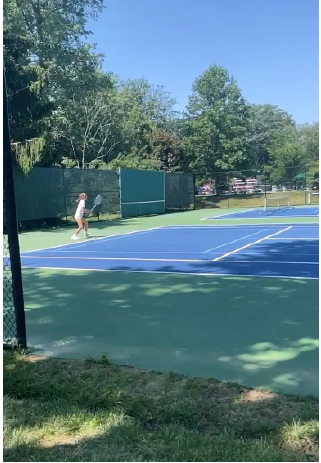
Figure 4. An outdoor tennis court among trees.